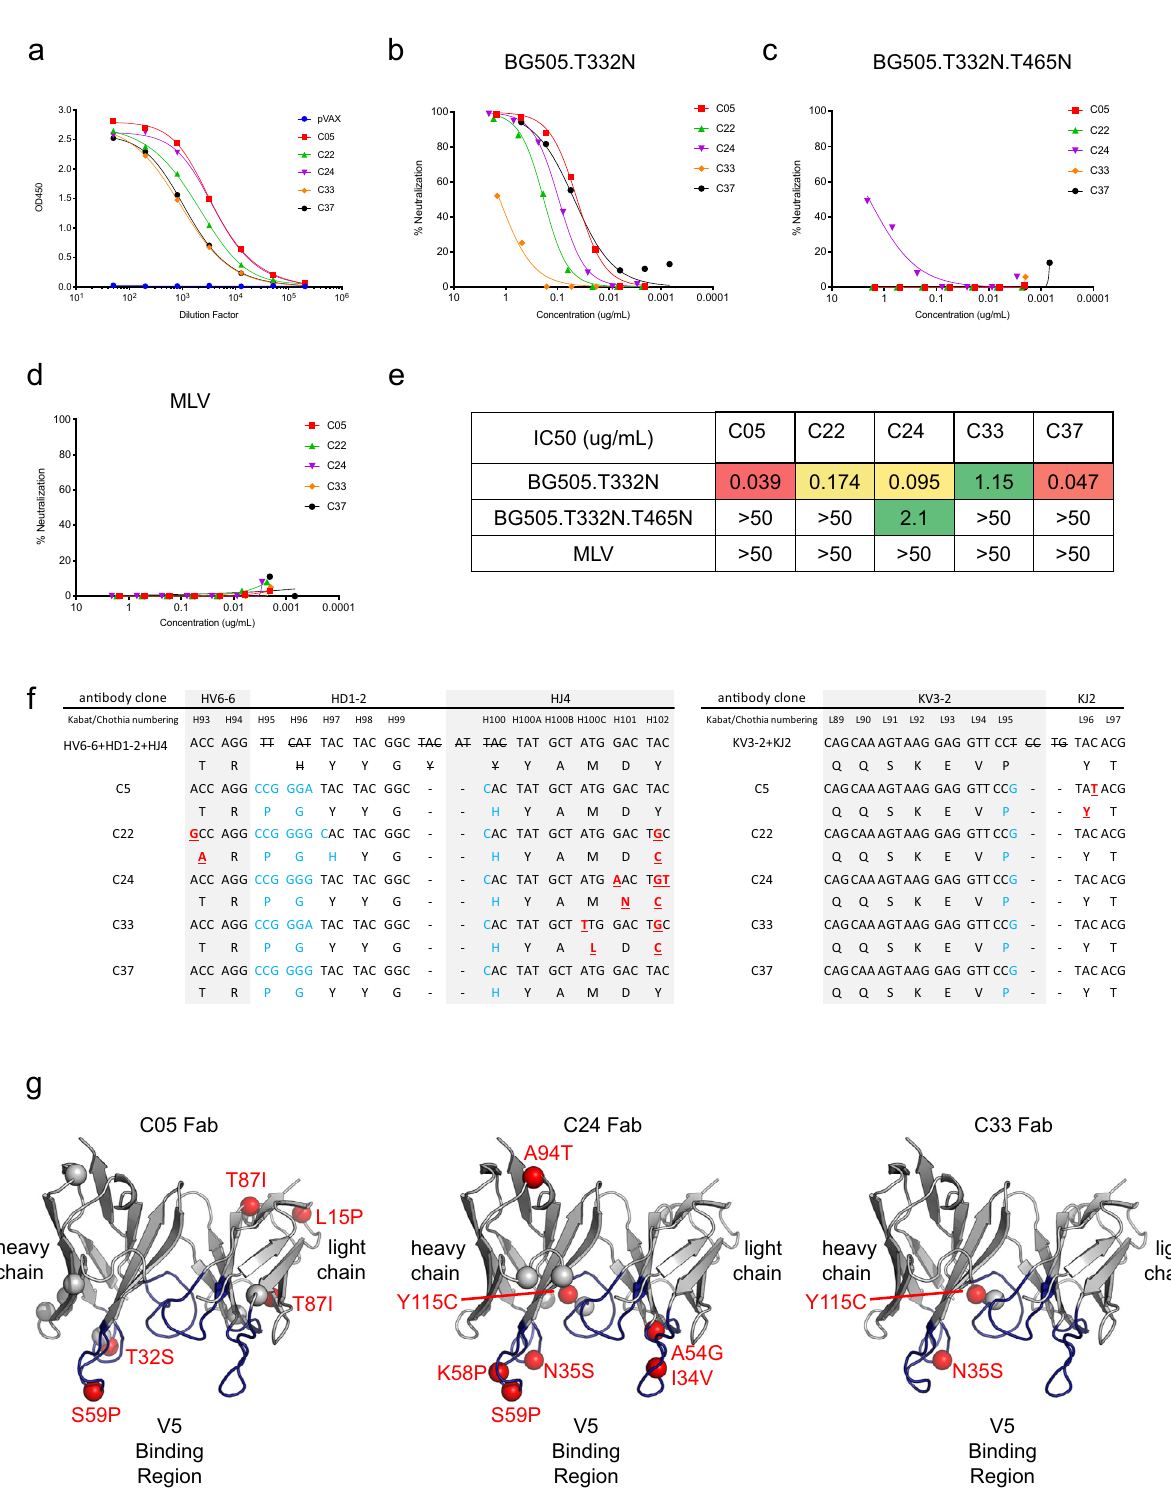
Fig. 6 Isolated trimer-speci fi c murine MAbs neutralized BG505.T332N pseudovirus in a V5-dependent fashion. a Trimer-speci fi c binding of 5 isolated murine MAbs and PGT128 in Expi293F transfection supernatant. b – d Neutralization of BG505.T332N ( b ), BG505.T332N.T465N ( c ), and MLV ( d ) pseudoviruses with varying concentrations of murine trimer-speci fi c MAbs or PGT128. e Determined IC50 values in ug/mL of trimer-speci fi c murine MAbs for BG505.T332N, BG505.T332N.T465N, or MLV. f Amino acid alignments of the HCDR3 and LCDR3 regions of the identi fi ed BG505.MD39-speci fi c murine antibody clones as compared to the corresponding germline sequences. g Predicted Rosetta structures of the Fabs of clones C05, C24, and C33, positions mutated from the germline sequences are displayed in